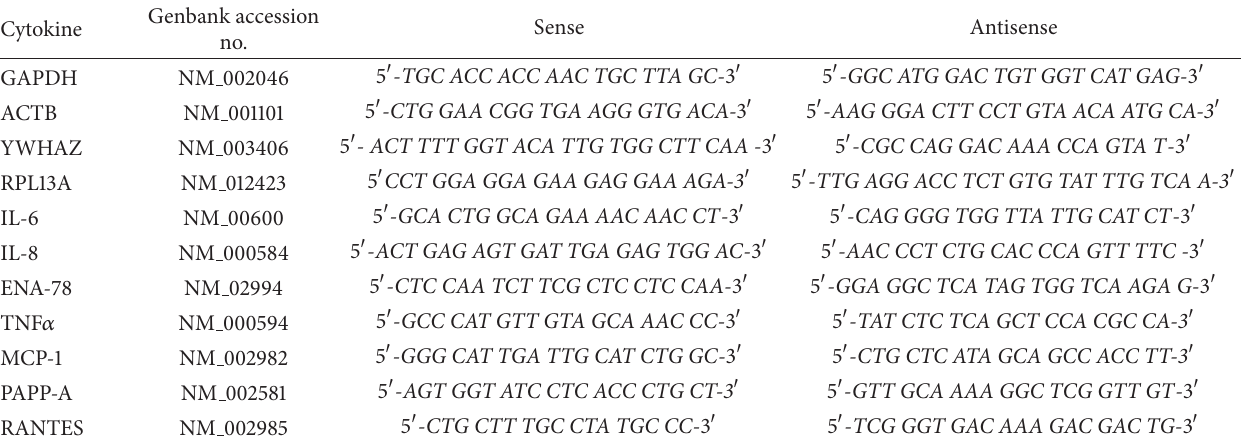
Table 1: Primer sequences of the reference genes and genes of